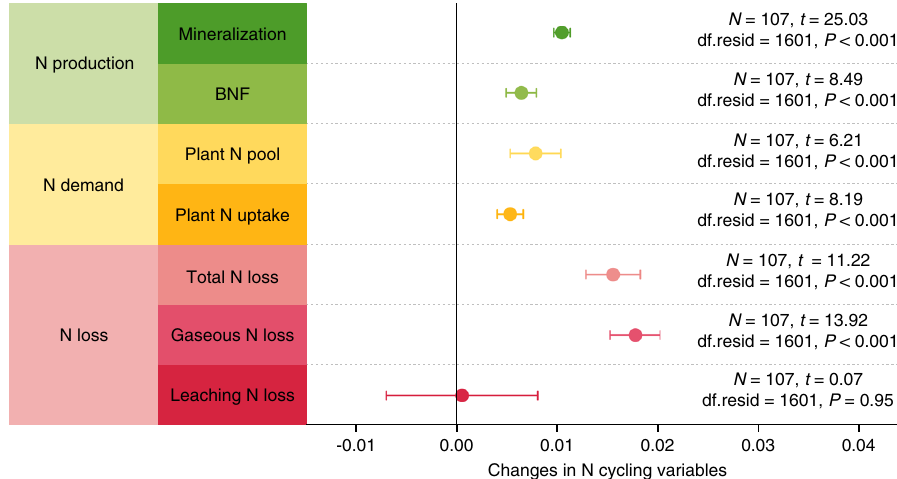
Fig. 3 Temporal dynamics of N production, demand and loss. Changes in production of available N are re fl ected by annual soil N mineralization and biological N fi xation rates (BNF), changes in plant N demand are represented by plant N pool and annual plant N uptake rate, and changes in ecosystem N loss are indicated by gaseous N loss, leaching N loss and total N loss (sum of gaseous and leaching N losses) over 2000s~2010s. Data of the N cycling variables were derived from the DeNitri fi cation-DeComposition (DNDC) simulations. Changes in N cycling variables were characterized by the slope of relationship between an indicator and the fi xed effect (year), which were examined with linear mixed-effects models after data normalization. Points in the plot denote the estimated model slopes and error bars represent 95% con fi dence intervals. N , the number of sites used for analyzing temporal dynamics of each indicator; df.resid, residual degrees of freedom.